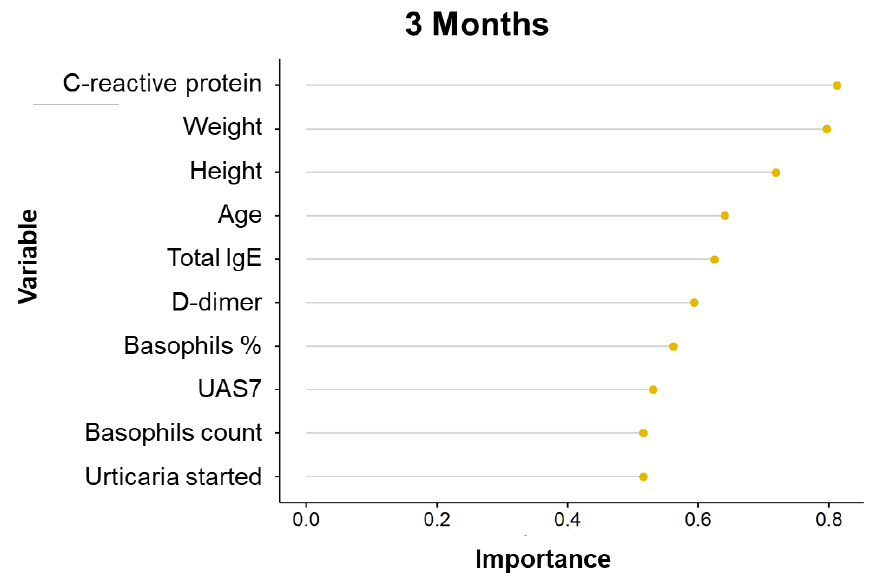
Figure 5. Variable Importance Analysis for the prediction of the response to omalizumab after 3 months treatment.